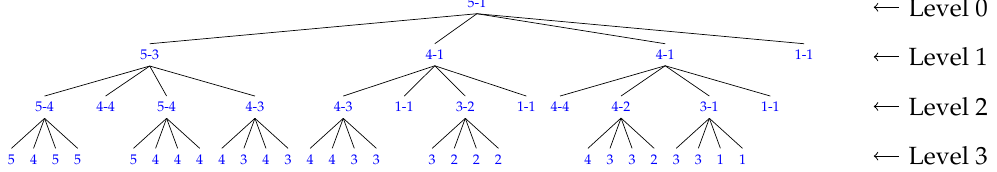
Figure 9. An example of an 8 × 8 matrix for k 2 -raster. The matrix is recursively partitioned into square subquadrants of equal size. During the process, unless all the cells in a subquadrant have the same value, the partitioning will continue. Otherwise the partitioning of this particular subquadrant will end at this point.